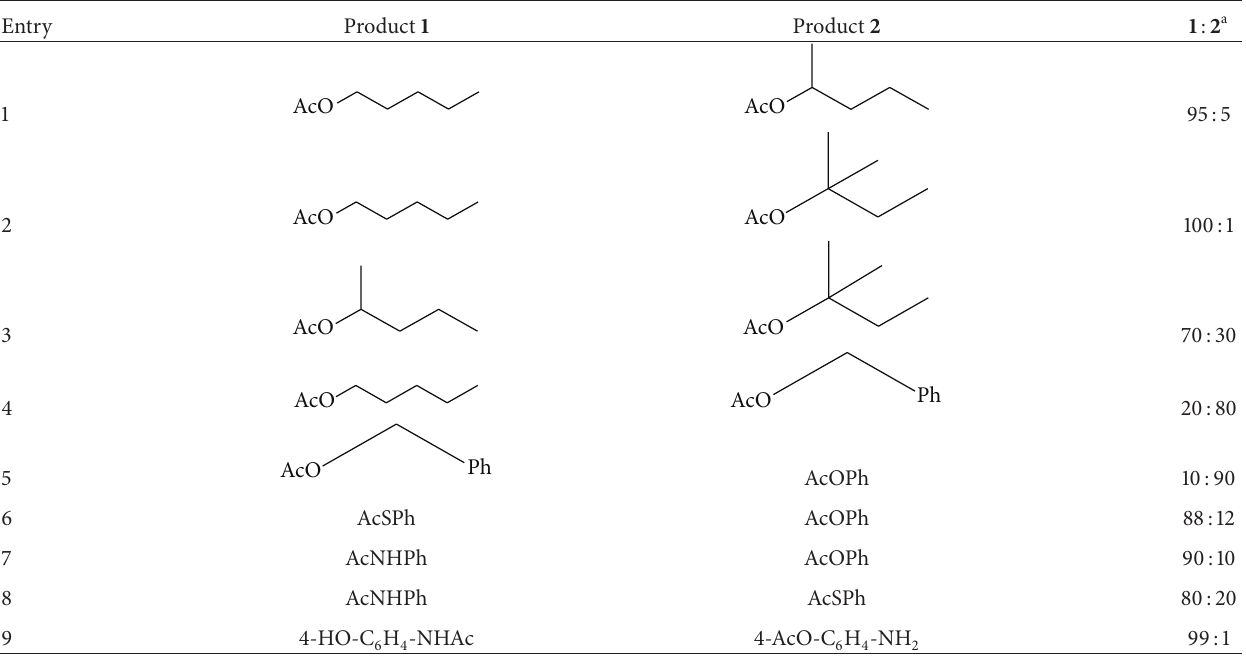
Table 3: Competitive acetylation of various functional groups with Ac